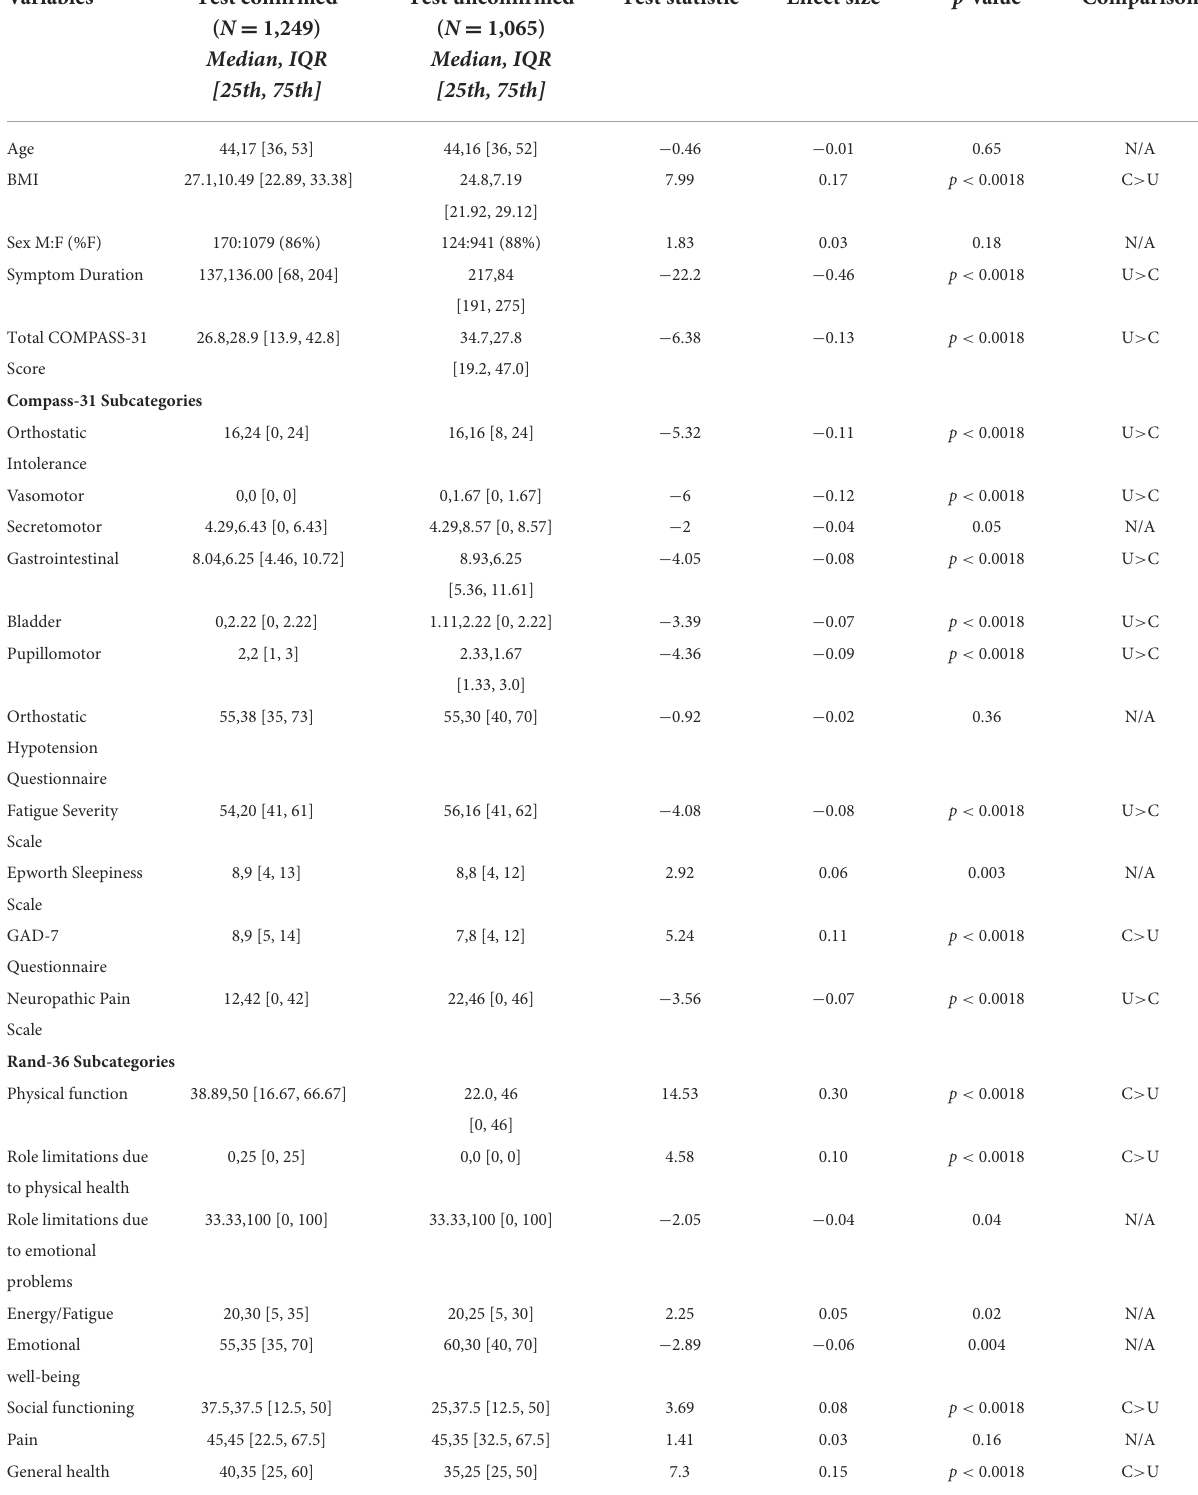
TABLE 4 Comparison of demographic variables and symptom scores in test-confirmed and test-unconfirmed